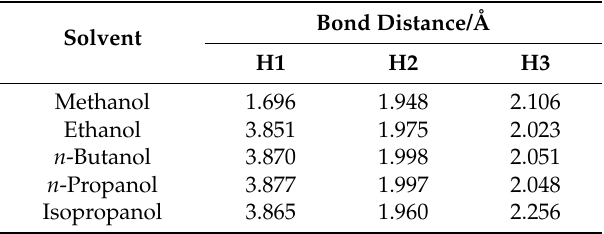
Figure 3. Interactions between metoprolol succinate and methanol; The dashed lines indicate hydrogen bonds of O–H with a distance (Unit: Å, 1 angstrom = 0.1 nm). Table 5. The values of distance of hydrogen bonds (H1, H2, and H3) of metoprolol succinate in different solvents calculated by density functional theory (DFT).